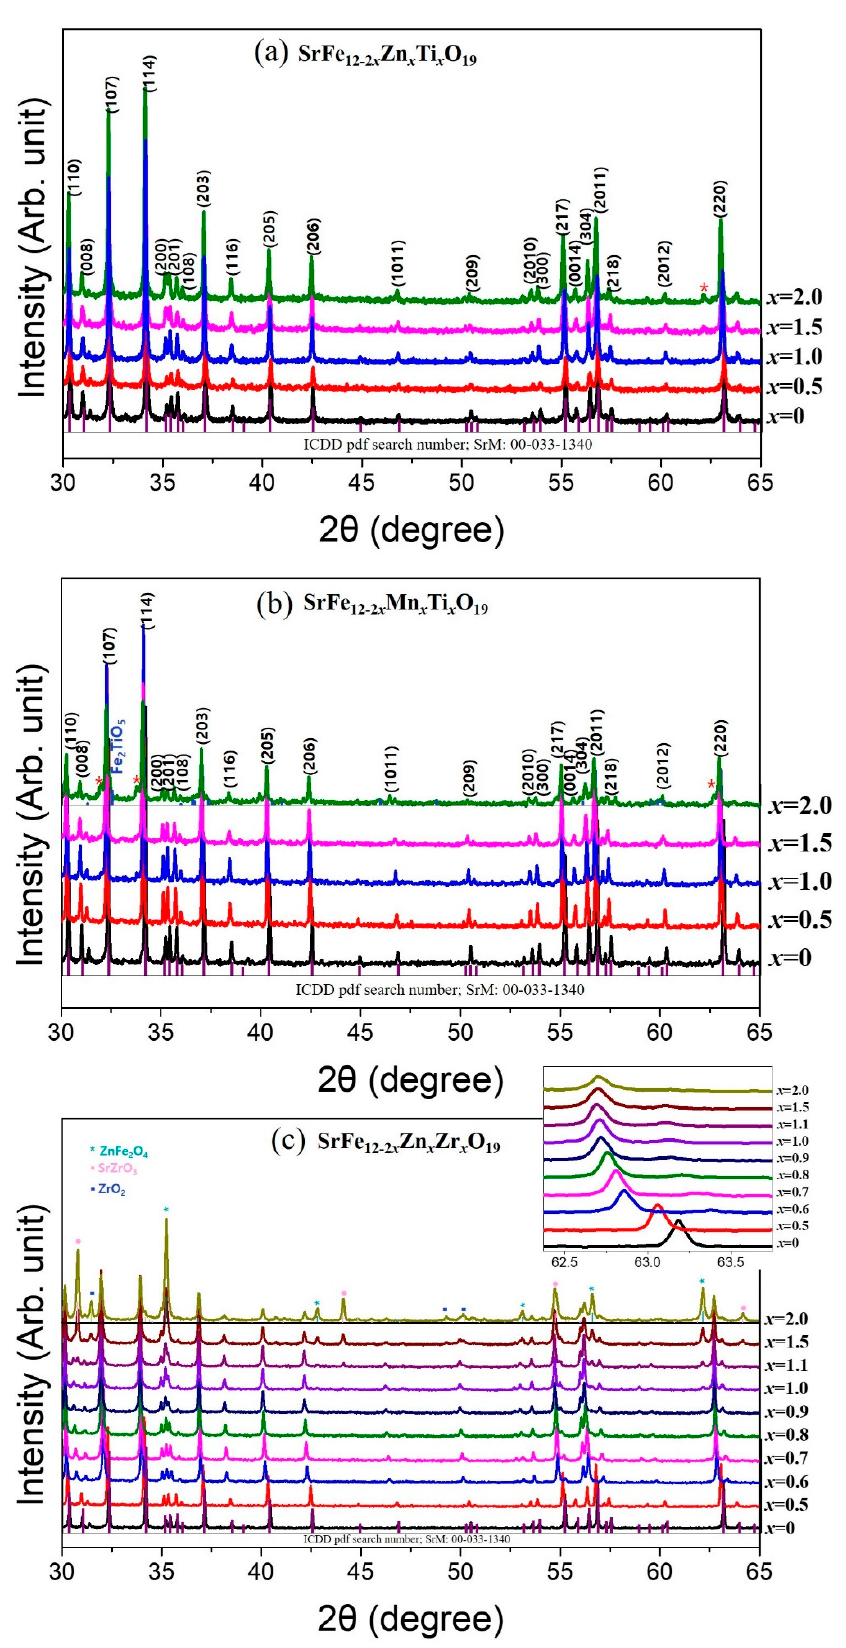
Figure 1. XRD patterns of ( a ) SrFe 12 − 2x Zn x Ti x O 19 ( x = 0, 0.5, 1.0, 1.5, 2.0), ( b ) SrFe 12 − 2x Mn x Ti x O 19 ( x = 0, 0.5, 1.0, 1.5, 2.0), and ( c ) SrFe 12 − 2x Zn x Zr x O 19 ( x = 0, 0.5, 0.6, 0.7, 0.8, 0.9, 1.0, 1.1 1.5, 2.0) samples.